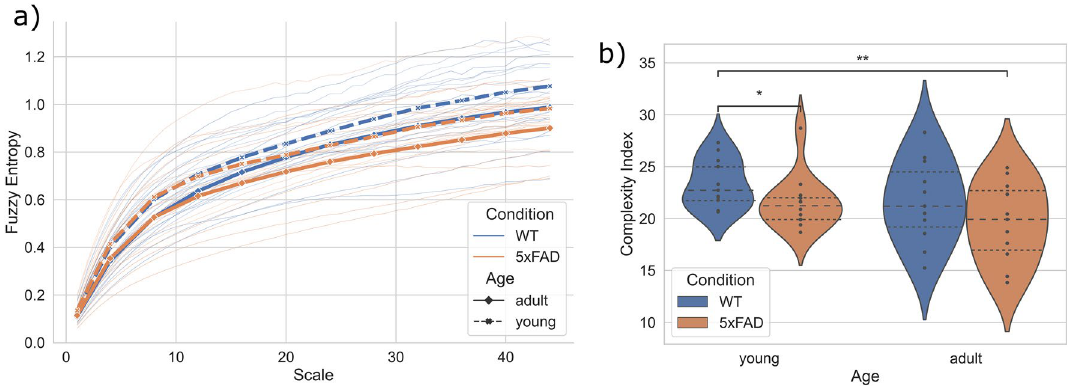
Figure 5. Multiscale entropy (MSE) analysis of µ ERG in response to a natural image sequence. ( a ) MSE curves of µ ERG responses for the natural image (NI) protocol. Thinner lines: MSE curves of all retinas; thicker lines: average MSE for groups WT-young, WT-adult, 5xFAD-young and 5xFAD-adult. ( b ) Complexity index, calculated as area under the MSE curve. Dashed lines: first, second ( i.e. , median) and third quartiles. *: p < 0.05 and **: p < 0.01 for Mann–Whitney U test.